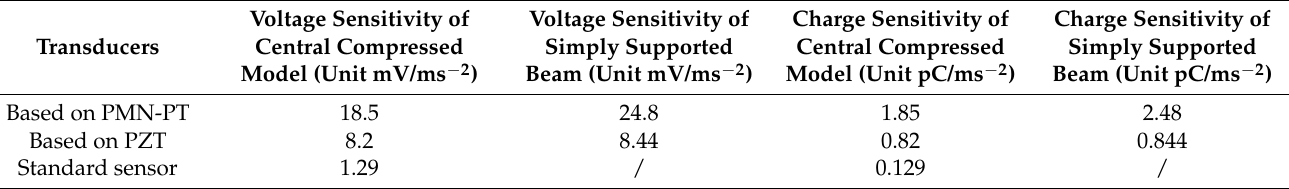
Table 2. The dimensions of piezoelectric elements and the simply supported beam used in this Table 3. The Sensitivity of the transducers of different work.